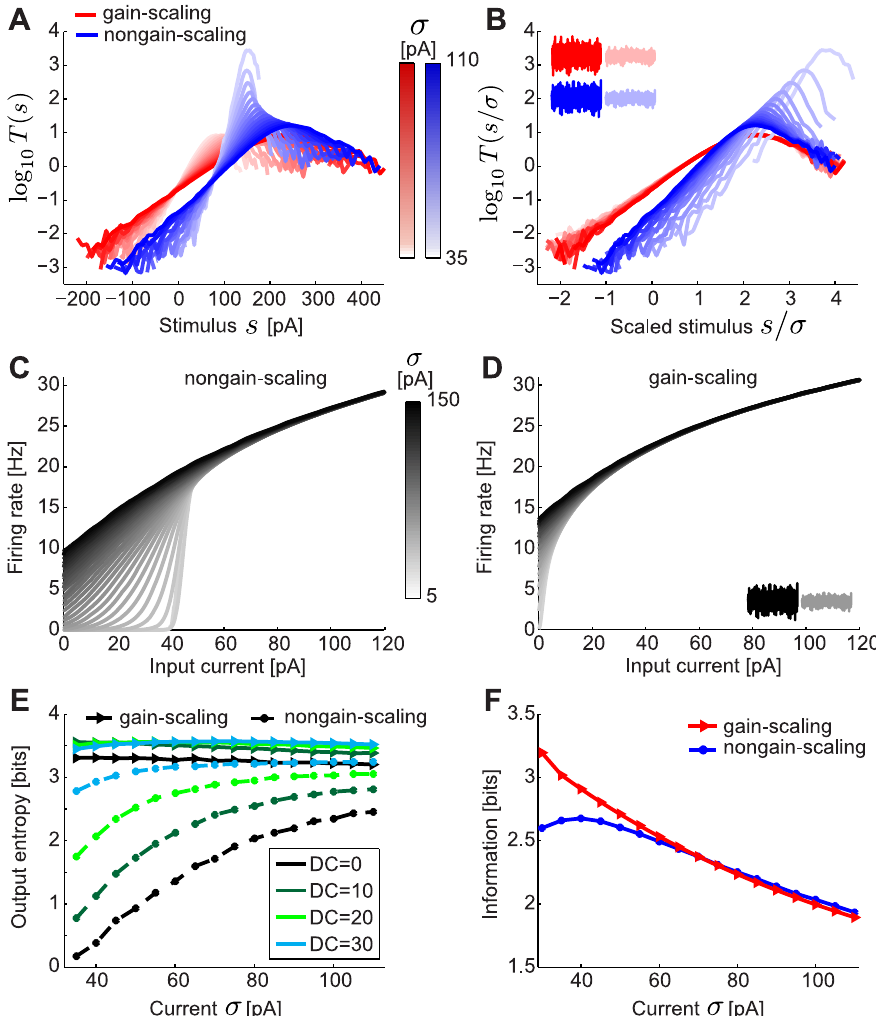
Figure 1. LN models and f – I curves for gain-scaling (GS) and nongain-scaling (NGS) neurons. A. The nonlinearities in the LN model framework for a GS (red) ( G K ~ 1000 pS/ m m 2 and G Na ~ 1500 pS/ m m 2 ) and a NGS (blue) ( G K ~ 1000 pS/ m m 2 and G Na ~ 600 pS/ m m 2 ) neuron simulated as conductance-based model neurons (Eq. 2). The nonlinearities were computed using Bayes’ rule: T ( s ) ~ P (spike D s ) = r ~ P ( s D spike) = P ( s ) , where r is the neuron’s mean firing rate and s is the linearly filtered stimulus (see also Eq. 7 in Methods). B. The same nonlinearities as A, in stimulus units scaled by s (magnitude of stimulus fluctuations). The nonlinearities overlap for GS neurons over a wide range of s . C–D. The f – I curves for a NGS (C) and a GS neuron (D) for different values of s . E. The output entropy as a function of the mean (DC) and s (amplitude of fast fluctuations). F. Information about the output firing rate of the neurons as a function of s .